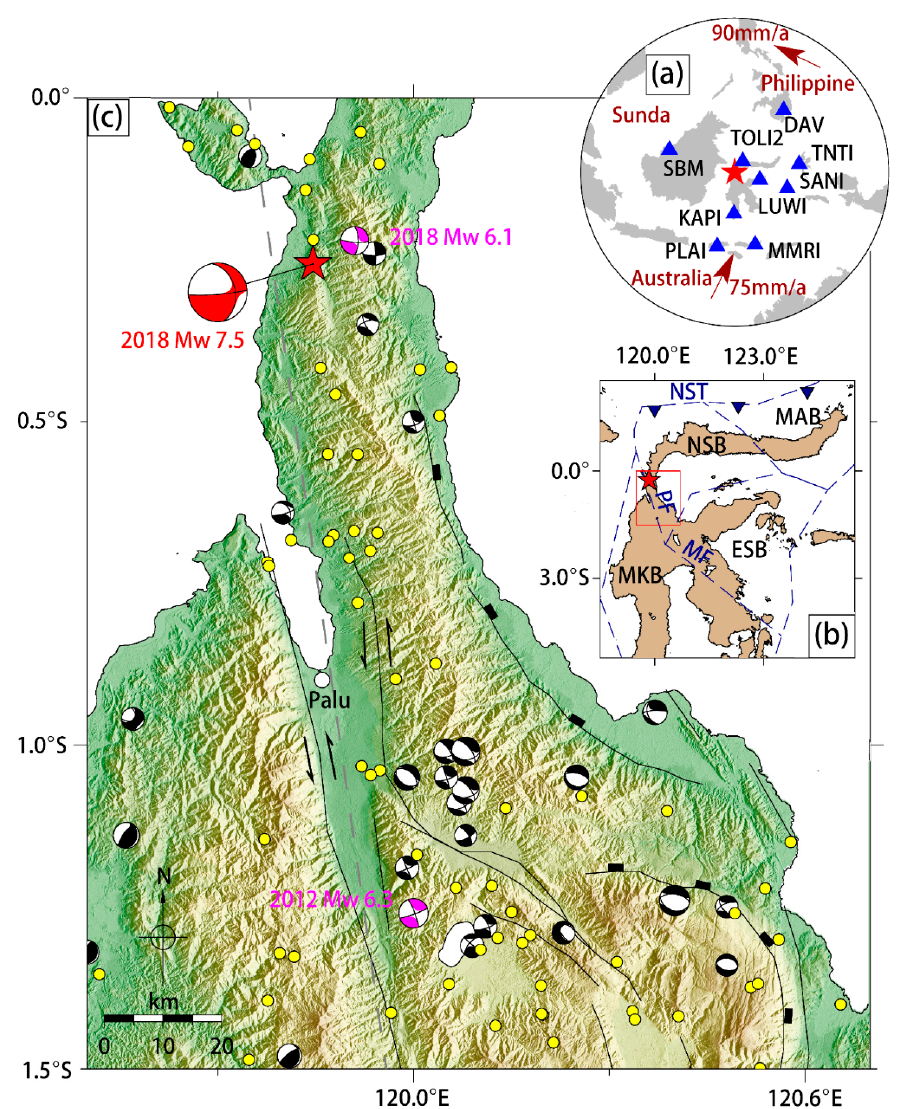
Figure 1. Tectonic setting of the 2018 Mw 7.5 Palu earthquake. ( a ) Dark red arrows show the convergent rates between the Philippine Sea, Australian, and Sunda plates. The red star marks the epicenter of the 2018 Palu earthquake. Blue triangles are the broadband regional stations used in this study. ( b ) Microblock model of Sulawesi [1] with the block boundaries depicted by dark blue dashed lines (modified from Wang et al. [4]). Red rectangle outlines the bounds of the panel ( c ). PF, Palu–Koro fault; MF, Matano fault; NST, North Sulawesi trench; NSB, North Sulawesi block; MAB, Manado block; ESB, East Sulawesi block; MKB, Makassar block. ( c ) Close-up of the epicenter region. The white circle